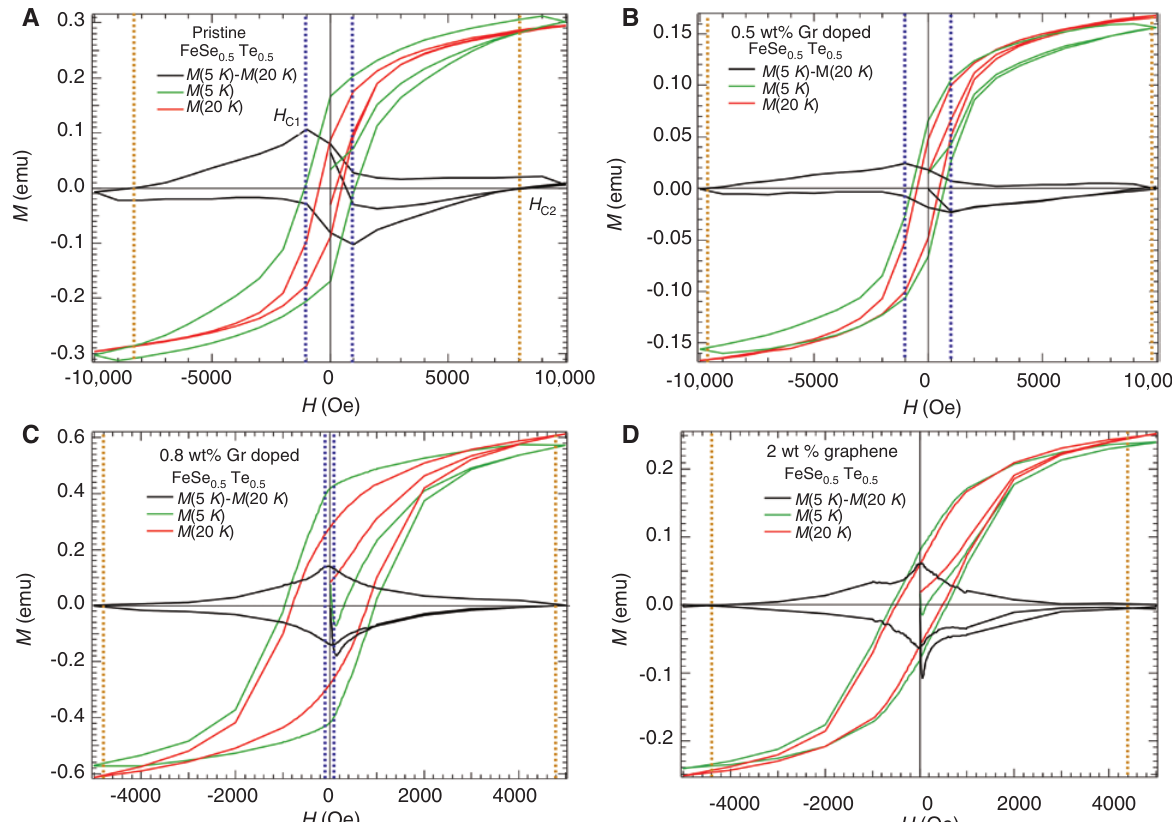
Te samples with (A) 0% wt., (B) 0.5% wt., 0.5 0.5 = M [ 5 K ]- M [ 20 K ]) clearly exhibits a shape typical of N and H for all c 1 c 2